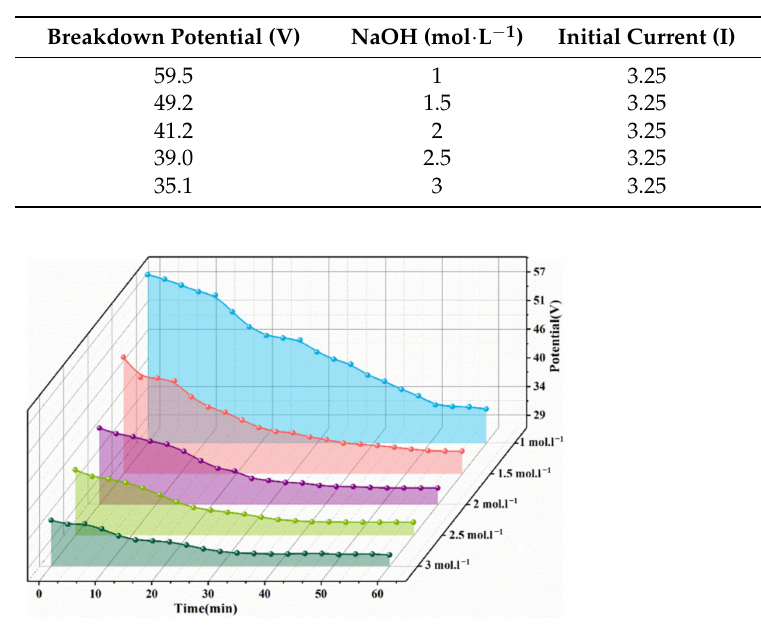
Figure 5. Relationship curve between potential and reaction time in the process of synthesizing BNTO nanoparticles under different NaOH